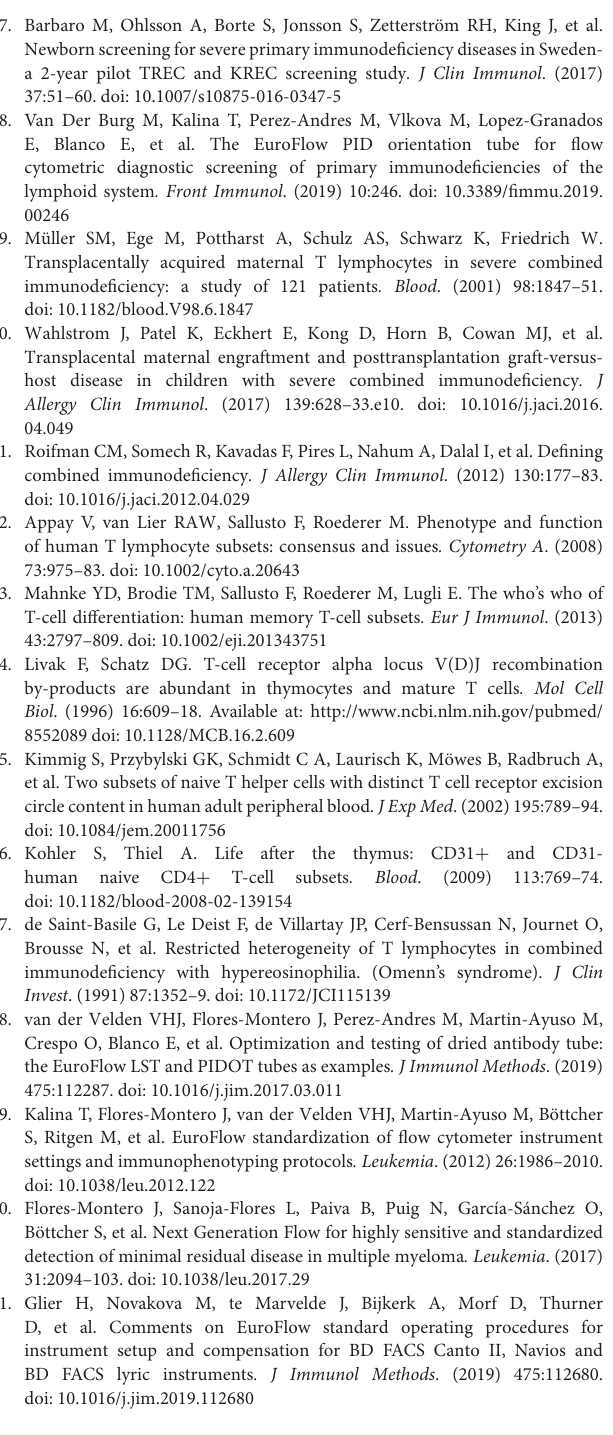
Supplemental Figure 1 | Detailed gating strategy. Supplemental Figure 2 | Detailed flow cytometry dot plots for SCID patients. Supplemental Figure 3 | Detailed flow cytometry dot plots for other PID